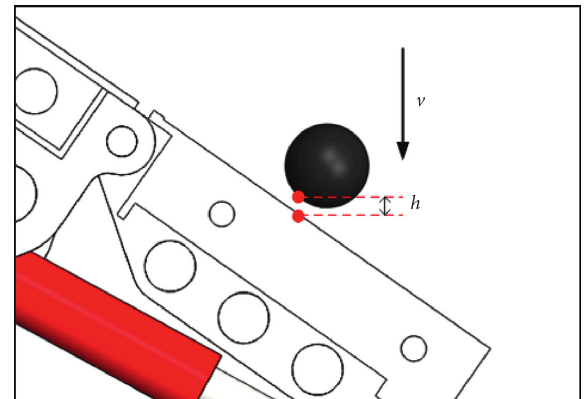
Figure 14: Working condition of coal gangue particles impacting tail